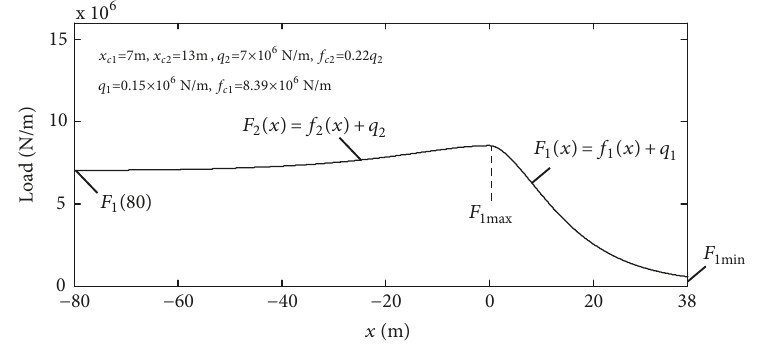
Figure 5: Load on roof in analysis and calculation.